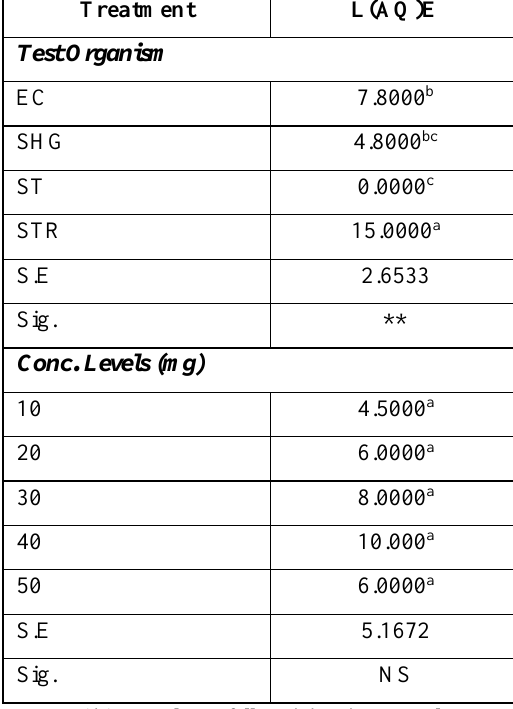
Table 8. The minimum inhibitory concentration of aqueous leave extracts of Moringa oleifera on test organisms.